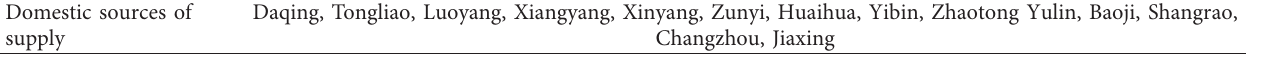
Table 2: Source, destination, and port hub.